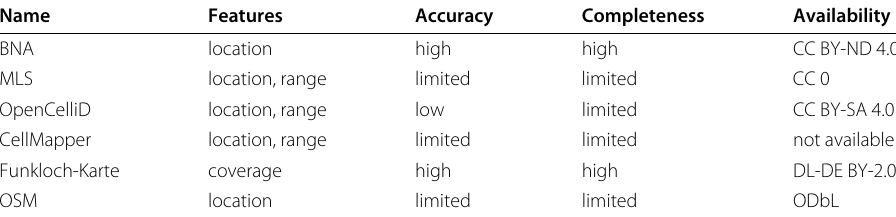
Table 1 Review of the observed ICT data